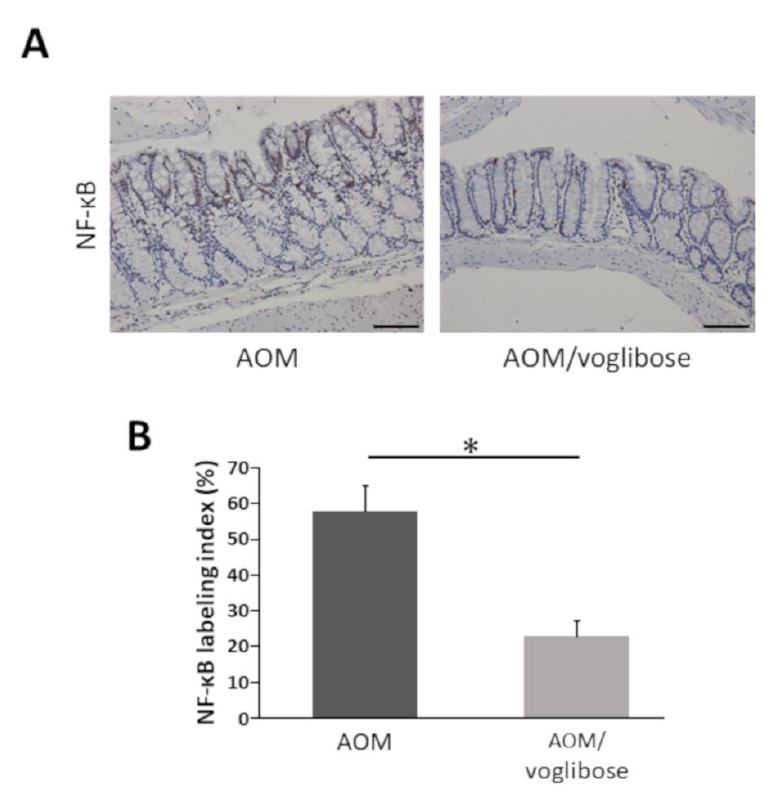
Figure 4. Effects of voglibose on the NF-κB activity in the colonic mucosa of experimental mice. Sections of the colon were stained with anti-phospho-NF-κB p65. ( A ) Representative photographs from each group, mice treated with AOM alone and mice treated with AOM plus voglibose, are shown. ( B ) The positive cell indices, which were determined by counting phospho-NF- κ B p65-positive cells, are shown. Bars, 100 µ m. Asterisk, statistical significance ( p <